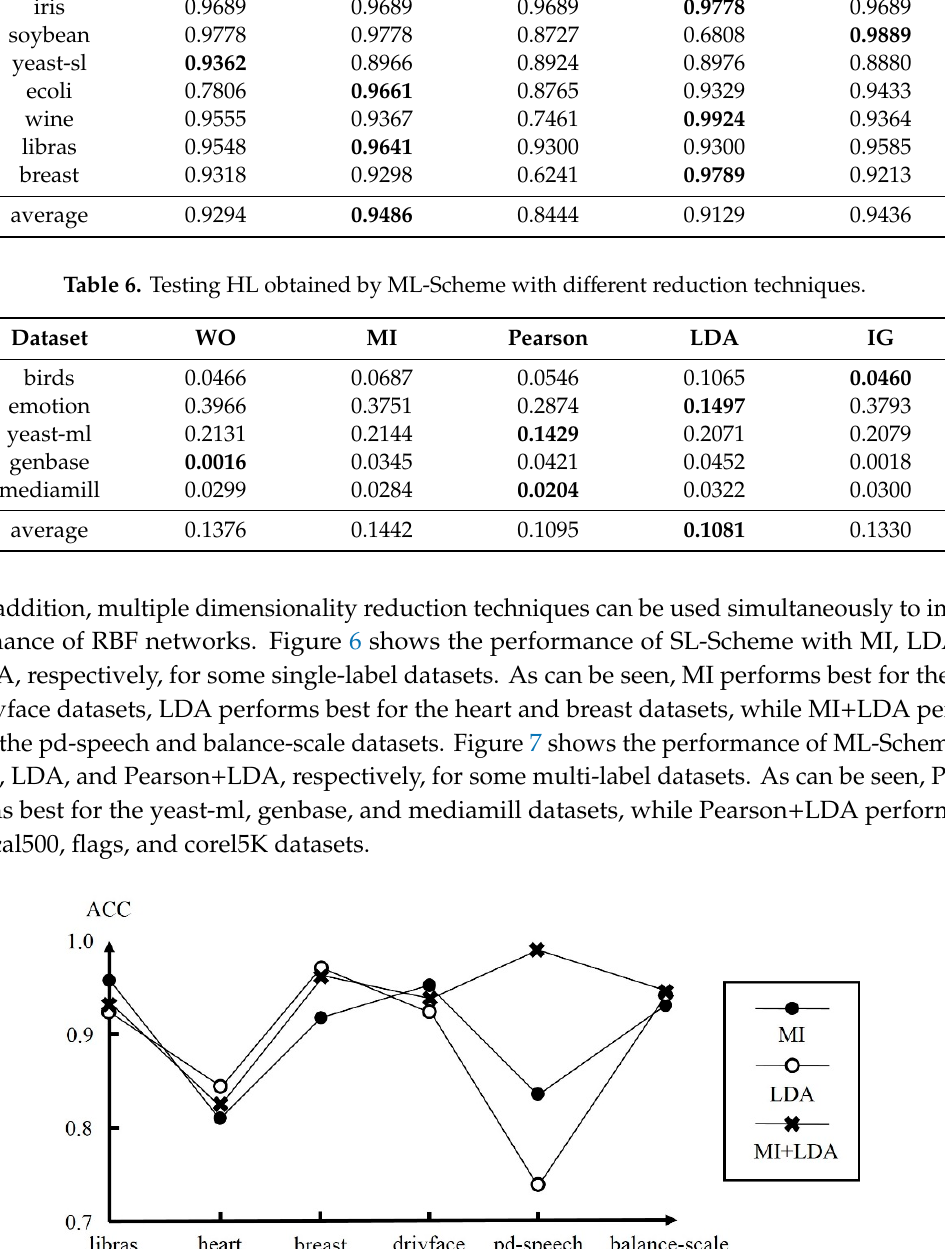
Figure 7. Performance of ML-Scheme with Pearson, LDA, and Pearson+LDA. 4.4. Discussions The contributions of this work include the determination of the number of neurons in the hidden layer, proposing SL-Scheme and ML-Scheme, respectively, for single-label and multi-label classification, and integrating different techniques to reduce overfitting for multi-class classification. As a result, a classification system can be built more easily due to the simplicity of the schemes and